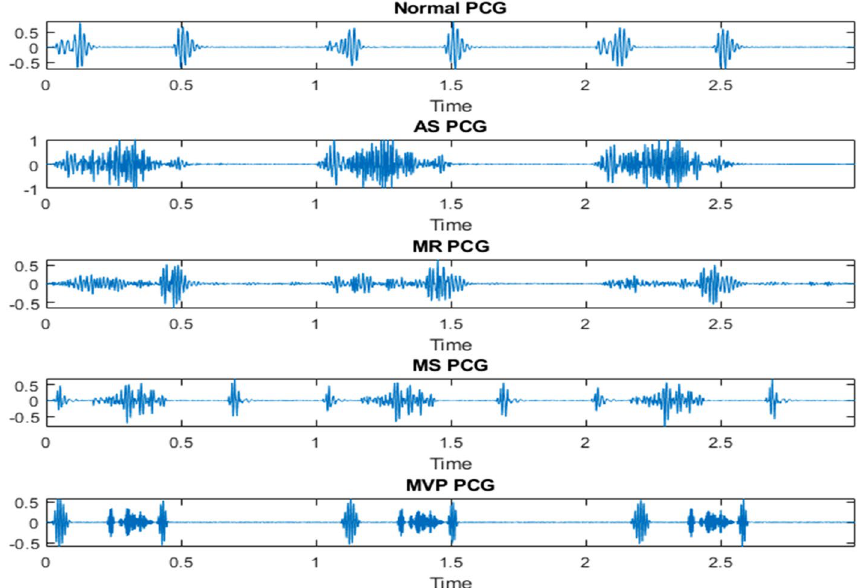
Figure 2. Sample PCG records from the first dataset.